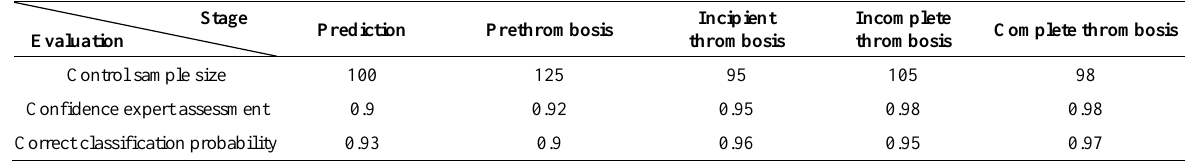
Table 5. Evaluation results and experts'